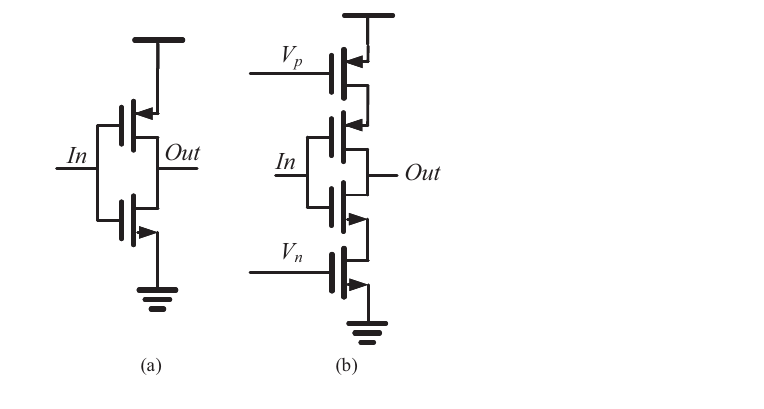
Figure 2. Schematics of ( a ) regular inverter and ( b ) current starved